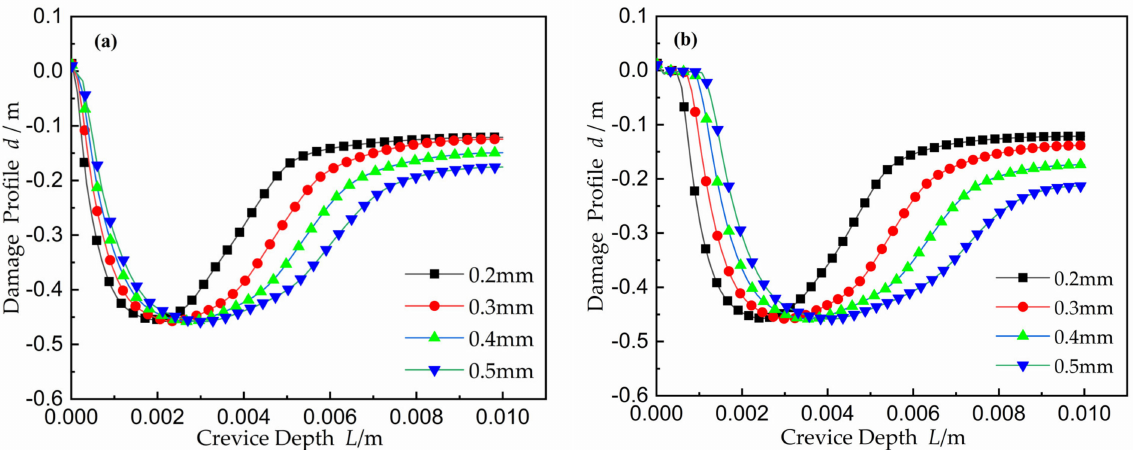
Figure 12. Electrode damage as a function of crevice width after 50 h: ( a ) the applied potential E A = 0.25 V; ( b ) the applied potential E A = 0.30